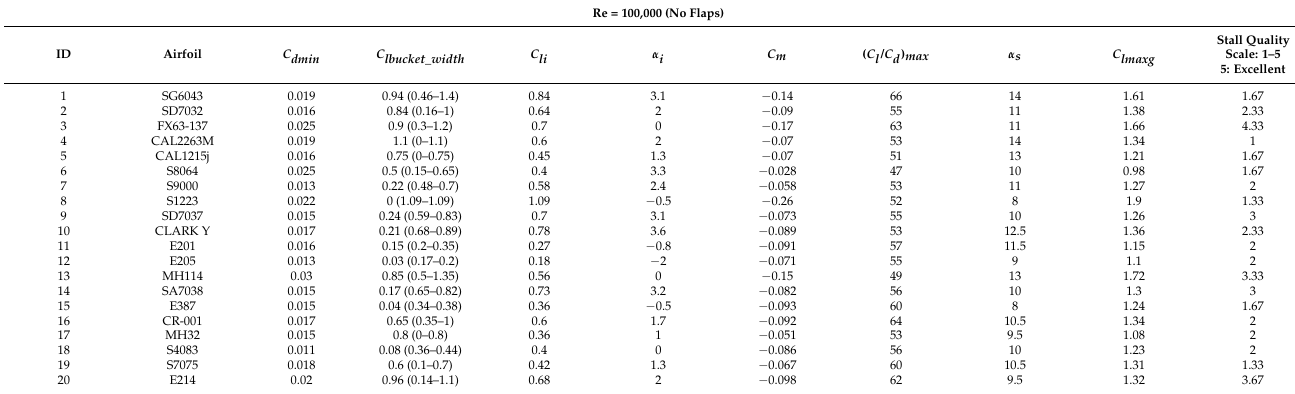
Table 6. Measurements of interest at Re = 100,000 and no flap usage.